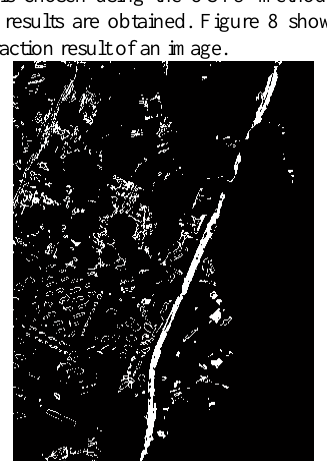
Figure 8. An example of initial road extraction results from an image